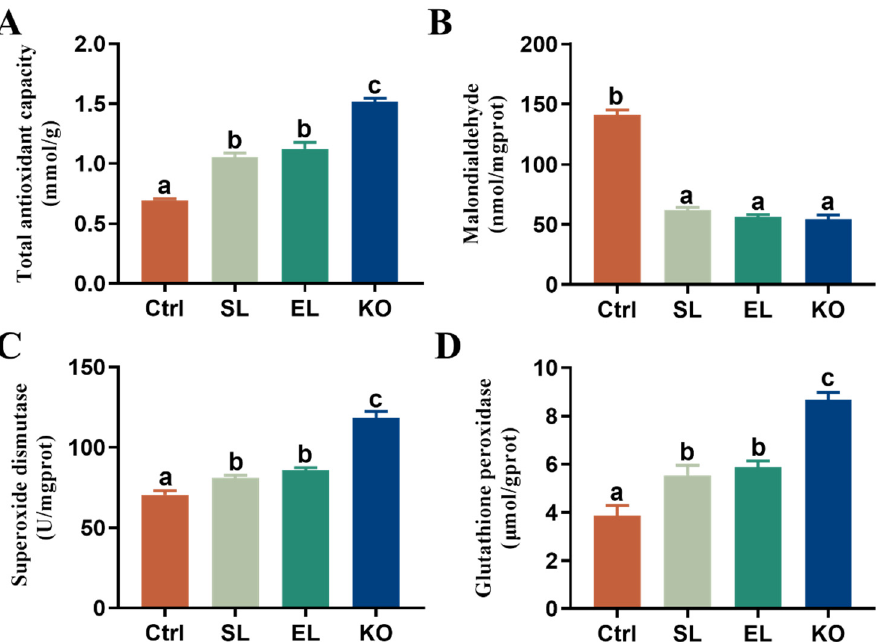
Figure 2. Hepatopancreatic antioxidant ability of female L. vannamei fed different experimental diets. ( A ) Total antioxidant capacity (T-AOC). ( B ) Malondialdehyde (MDA). ( C ) Superoxide dismutase (SOD). ( D ) Glutathione peroxidase (GSH-Px). The values are the mean ± standard errors ( n = 4). Values with superscript different letters indicate significant differences ( p < 0.05) among all the treatments.